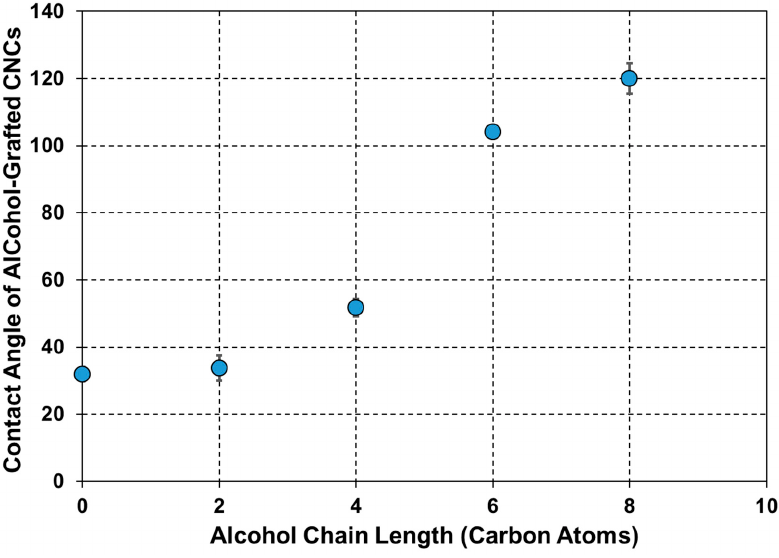
Figure 5. The dependence of the contact angle of the modified CNCs on the chain length of the alcohols grafted onto their surfaces.